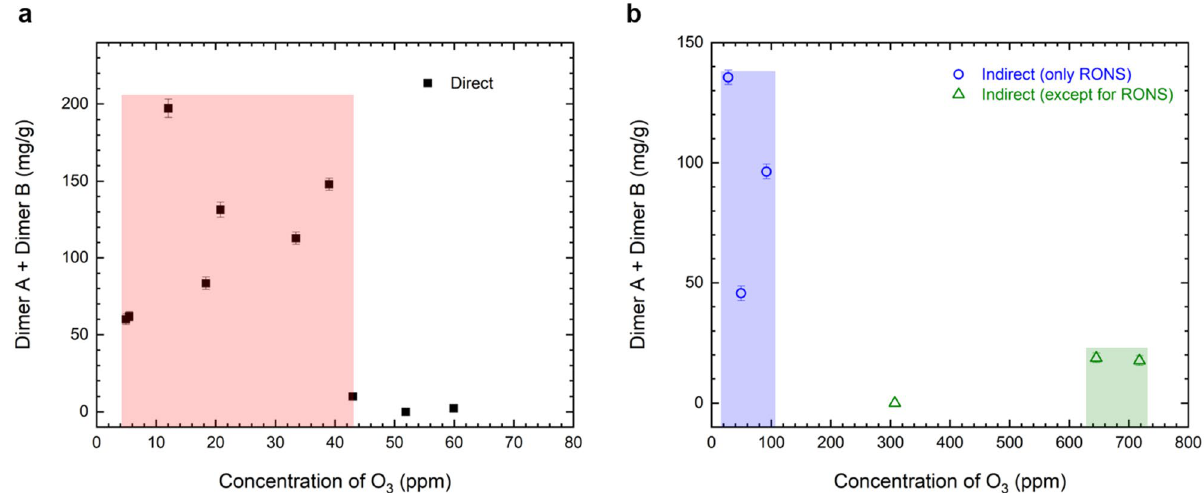
Figure 6. Contents of newly generated dimers A and B according to the plasma treatment method: ( a ) direct plasma treatment, and ( b ) indirect plasma treatment.